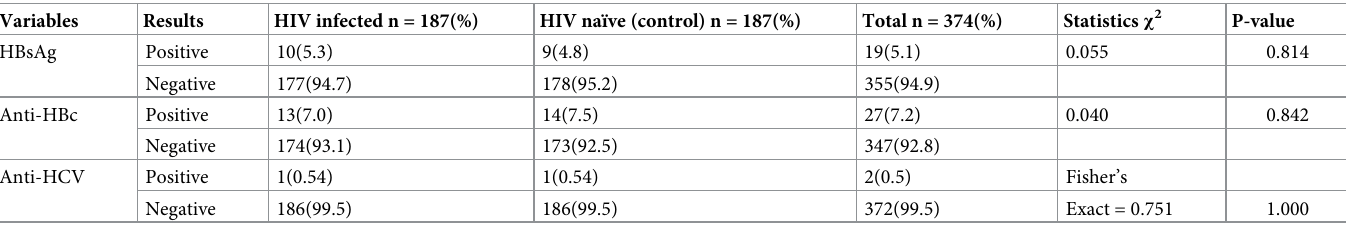
Table 2. Comparison of the prevalence of HBV and or HCV viral co-infections among HIV-infected and HIV na ï ve (controls) children.